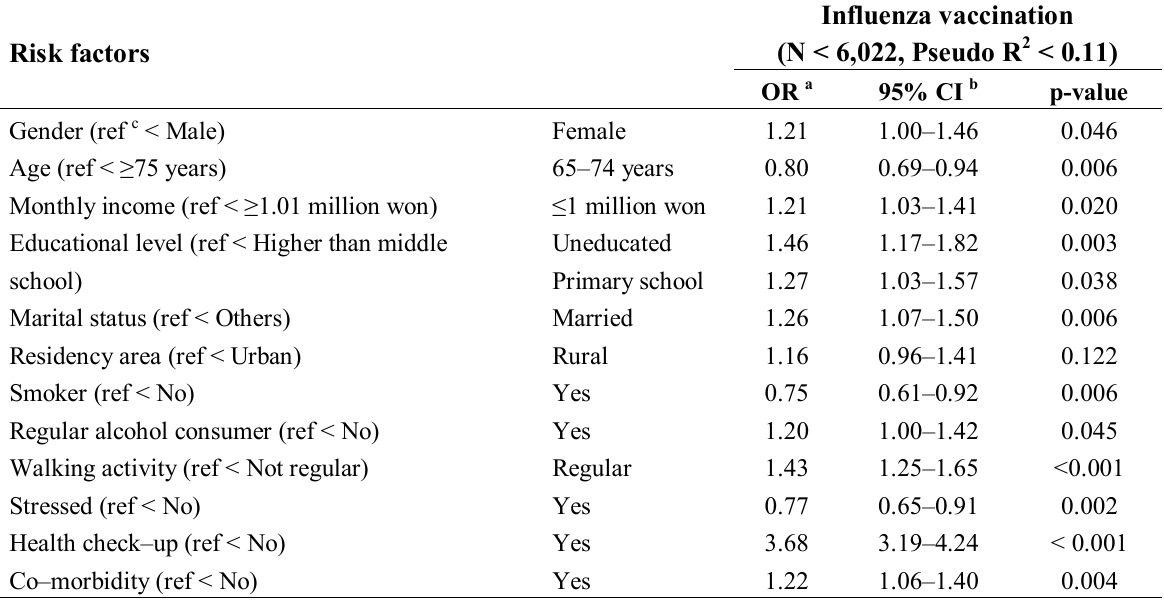
Table 5. The factors associated with influenza vaccination in the older adults. Risk